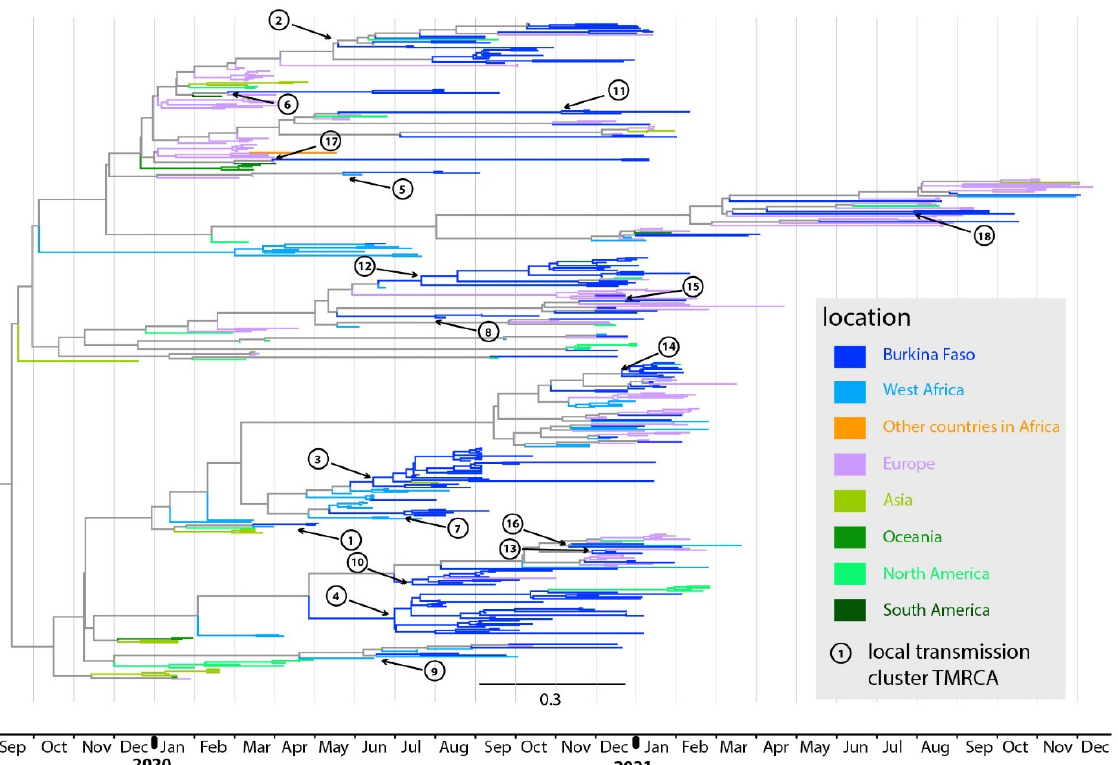
Figure 2. Dated phylogenetic tree showing the 18 transmission clusters identified in western Burkina Faso. The tree branches are color-coded according to each geographic region. The estimated time to the most recent common ancestor (TMRCA) values of Burkina Faso transmission clusters are highlighted by black arrows and circles with consecutive numbering according to the detection date (sample with the earliest collection date within that cluster; see Table 1).